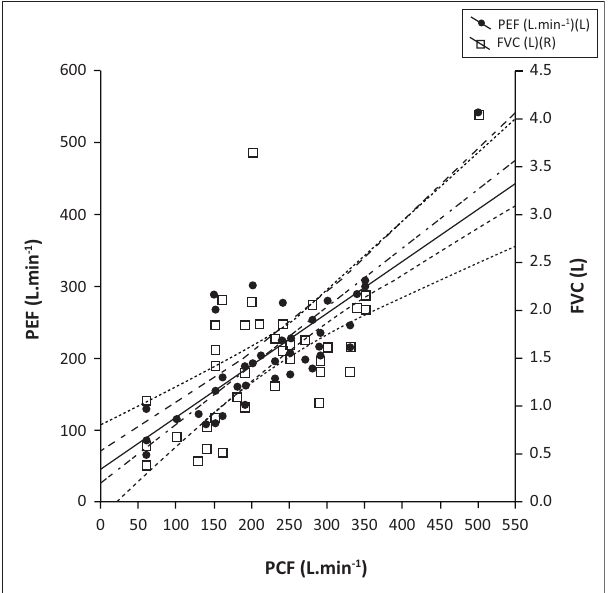
FIG URE 2: Correlation between peak cough flow (PCF) and peak expiratory flow (PEF) (Pearson’s R = 0.81; r 2 = 0.65; p < 0.0001) and forced vital capacity (FVC) (Pearson r = 0.67; r 2 = 0.44; p < 0.0001); n = 41. Linear regression equations: PEF = 26.46+0.82 ´ PCF; FVC = 0.24 + 0.005 ´ PCF.